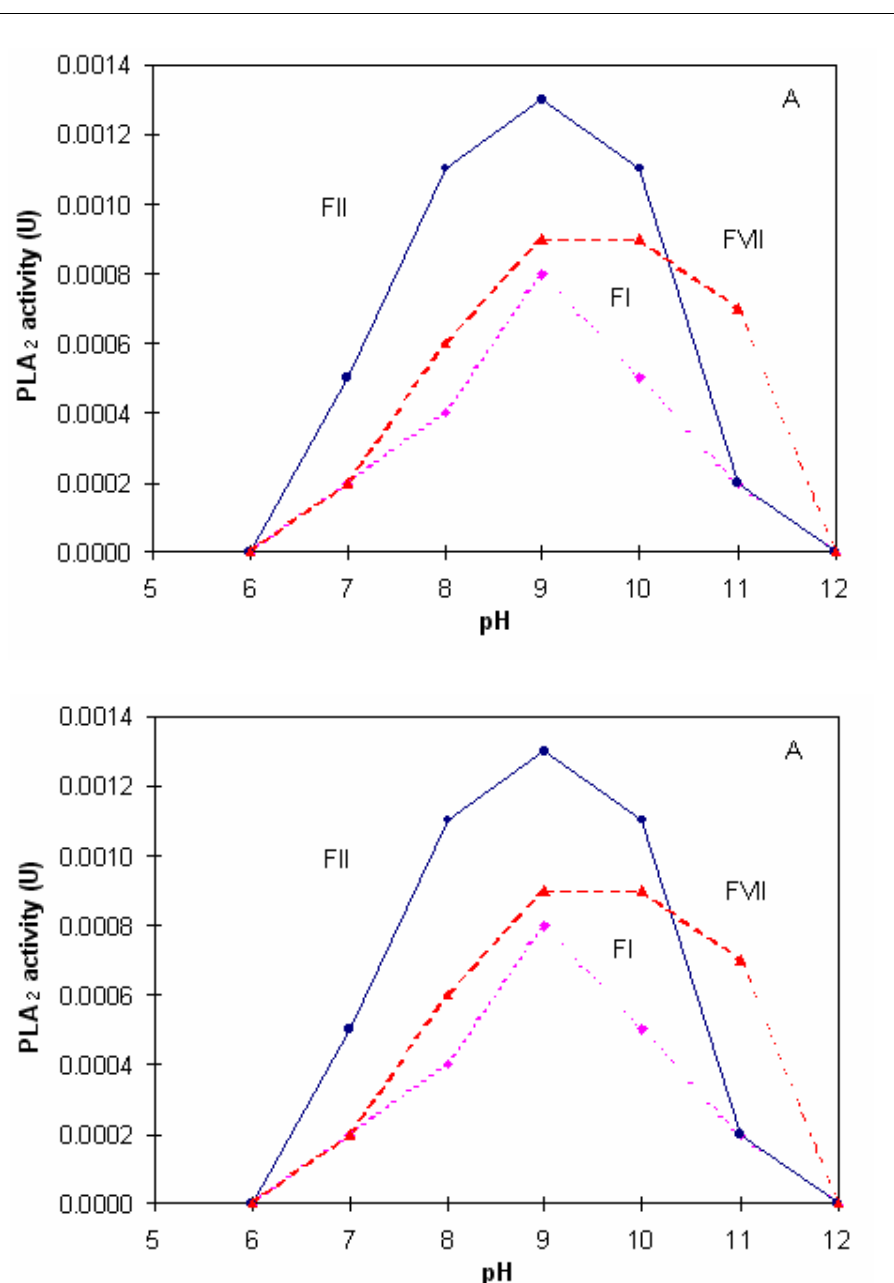
Figure 4. Effect of pH and temperature in the reaction velocity of the PLA asper